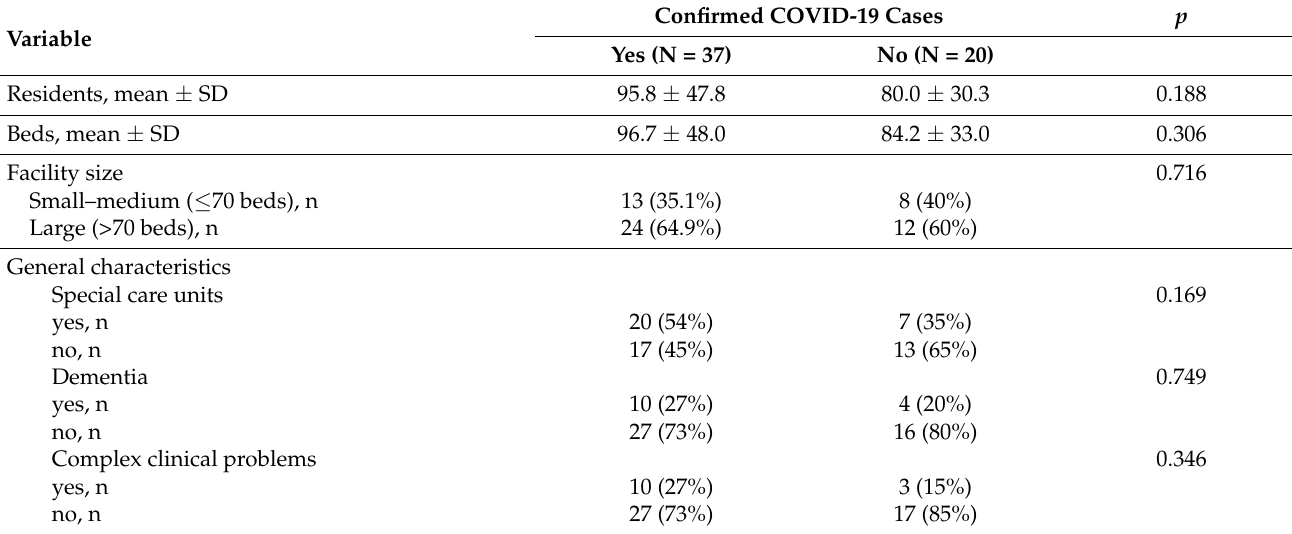
Table 3. Bivariate analyses for nursing homes in the province of Trento that reported COVID-19 cases and those that did not report any